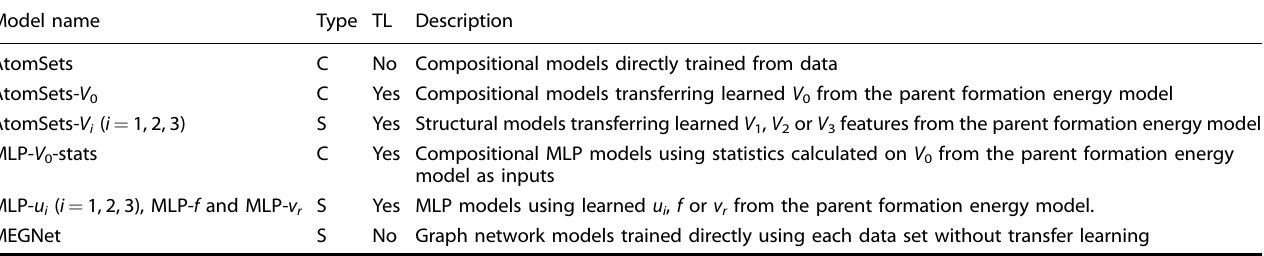
Table 1. Models investigated in this work, categorized by the models types, i.e., compositional (C) or structural (S), and whether they utilize transfer learning